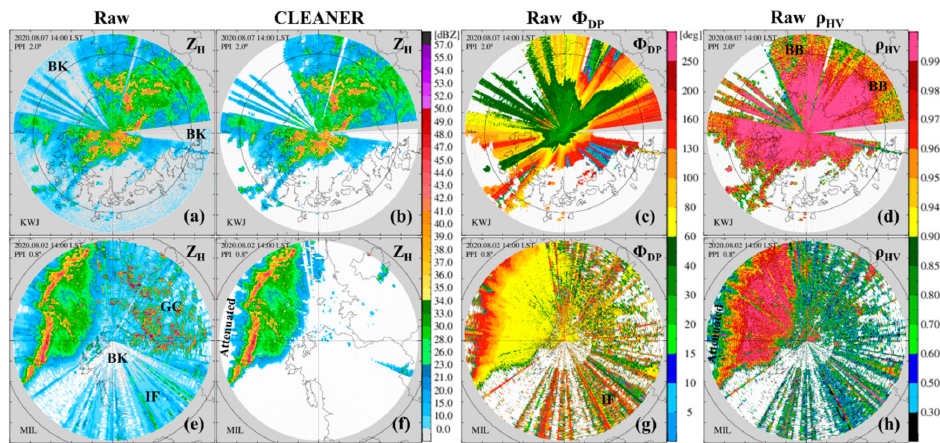
Figure 12. Reflectivity fields ( a , e ) before and ( b , f ) after applying CLEANER with ( c , g ) raw di ff erential phase and ( d , h ) correlation coe ffi cient fields collected by C-band polarimetric radar of KWJ of the air force an elevation angle of 2.0 ◦ at 1400 LST 7 August 2020 (top) and by KMA X-band radar for research an elevation angle of 0.8 ◦ at 1400 LST 2 August 2020 (bottom),